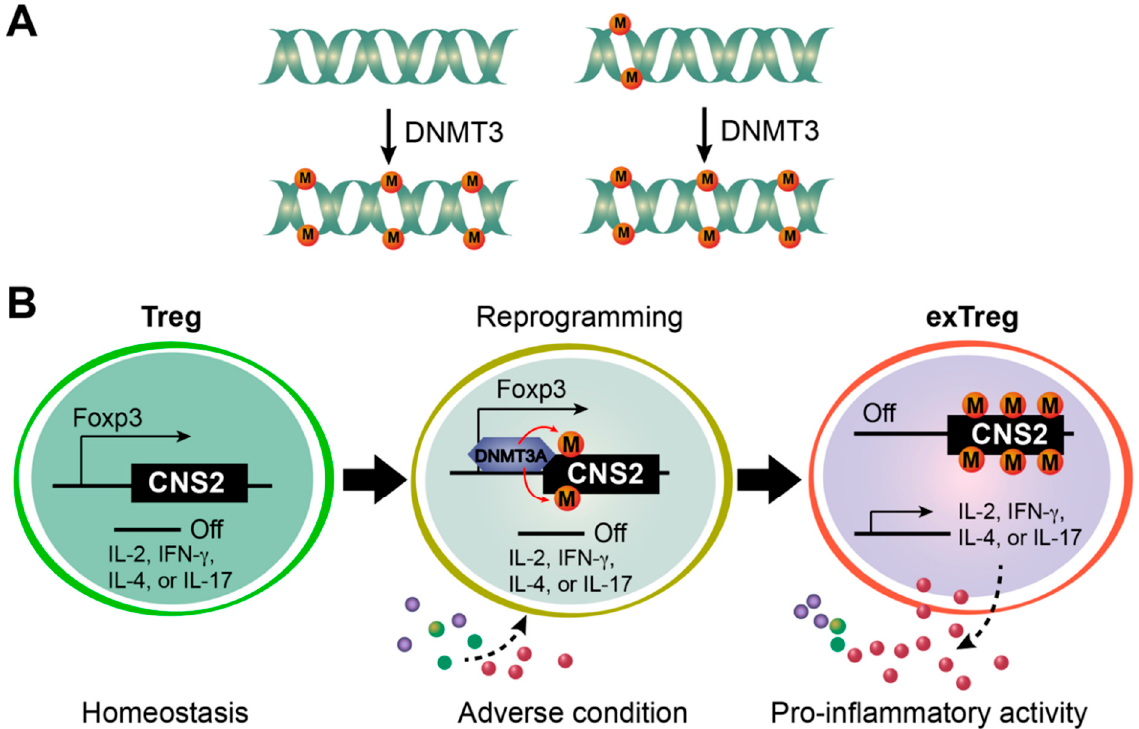
Figure 3. De novo DNA methylation in Treg cell transdifferentiation and reprogramming. ( A ) Sche- matic of de novo DNA methylation by DNMT3 (i.e., DNMT3A or DNMT3B), including methylation of new CpG sites and increased methylation levels of previous CpG sites at the population